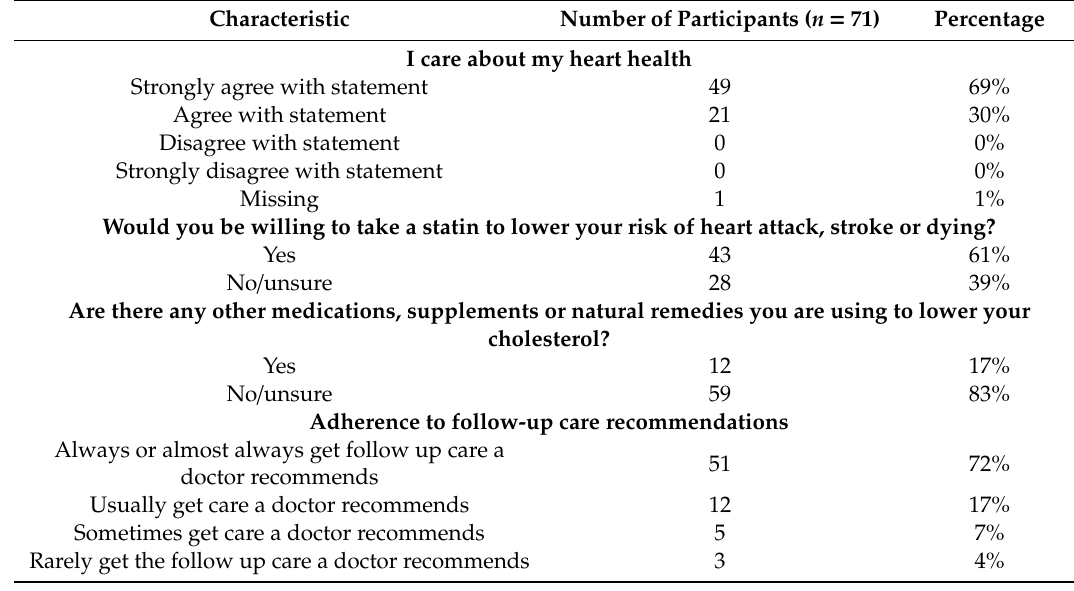
Table 3. Patient Interest in Cardiovascular Health and Follow-up